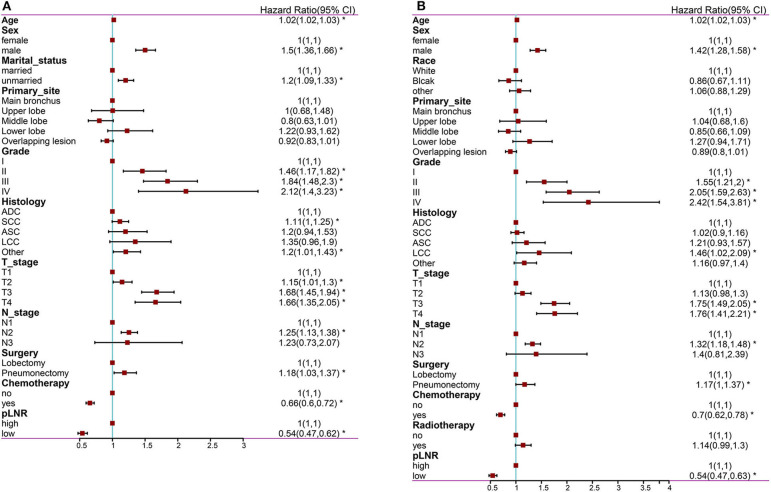
The forest map of Cox regression analysis. Multivariate Cox regression analyses estimating the risk factors for OS (A) and CSS (B). OS, overall survival; CSS, cancer-specific survival. *Means P < 0.05.